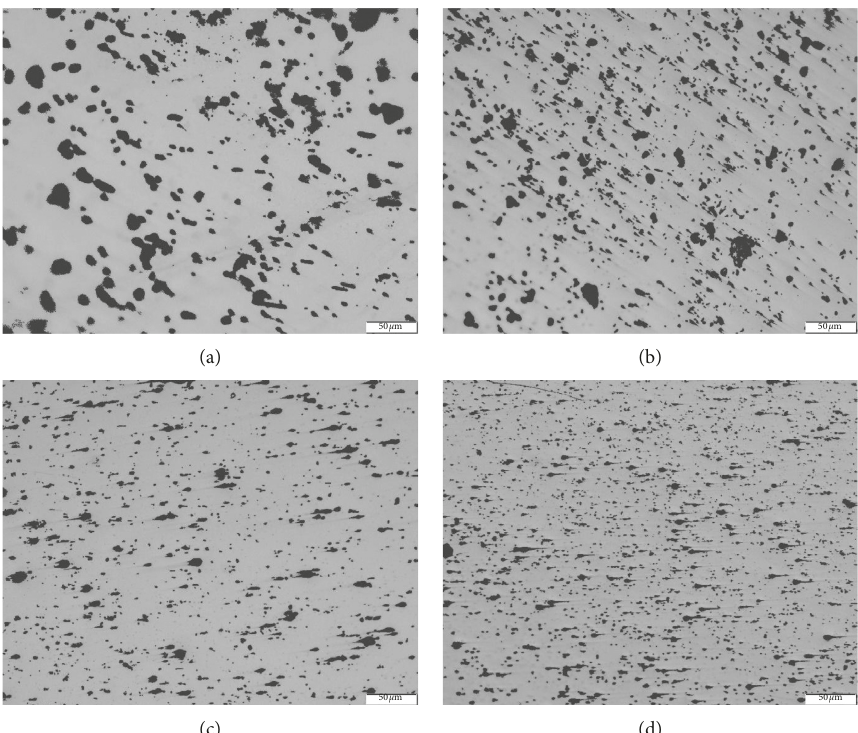
Figure 10: Particle morphology and population measured at (a) BM (14.4%) and SZ for samples welded with different feed rates: (b) 36mm/ min (12.1%), (c) 70mm/min (9.54), and (d) 140 mm/min